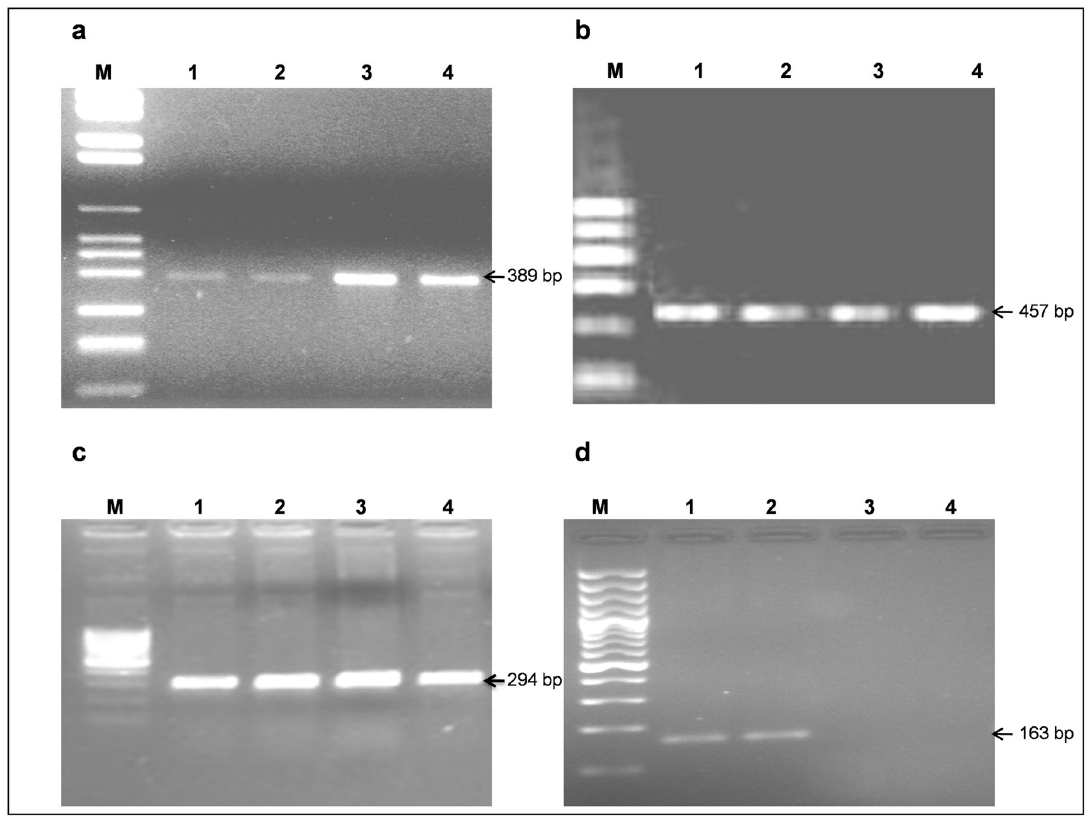
Fig 1. Agarose gel electrophoresis of the RT-PCR products. a) PCRs for AIEC. Lane M: Marker 100 bp; Lanes 1–4: AIEC positive samples; b) PCRs for L . monocytogenes . Lane M: Marker 200 bp; Lane 1: Positive control; Lanes 2–4: Positive samples; c) PCRs for C . jejuni . Lane M: Marker 100 bp; lane 1: Positive control; Lanes 2–4: Positive samples; d) PCRs for Y . enterocolitica . Lane M: Marker 100 bp; lane 1, 2: Positive